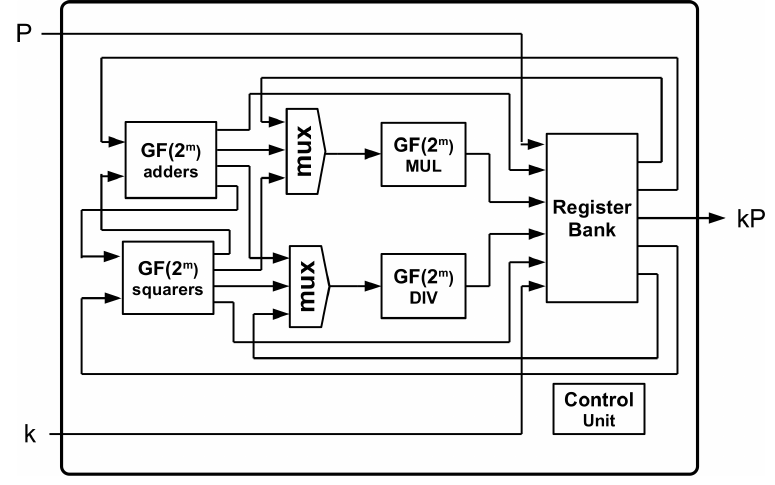
Figure 5. ECC scalar-point unit